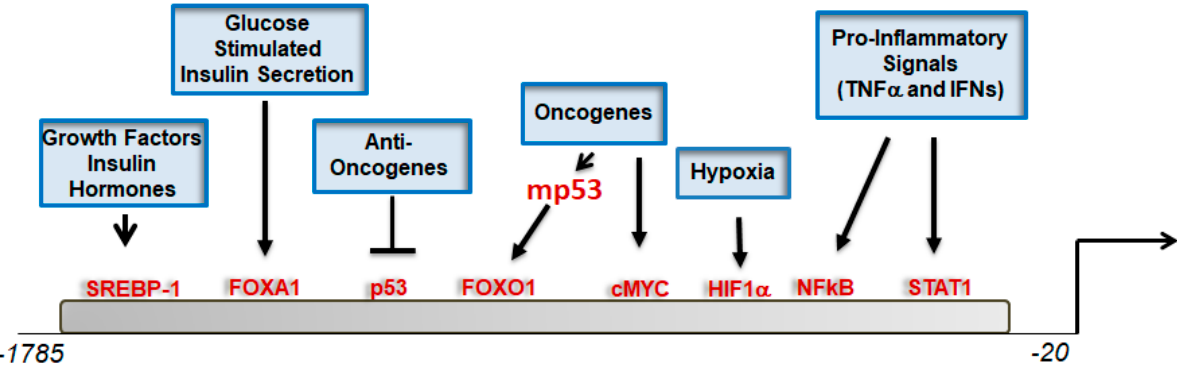
Figure 3. Schematic representation of the CIC promoter and transcription factors’ binding sites (TFBSs) identified in various studies. The positions of these TFBSs are representative and do not reflect the actual position in the promoter.